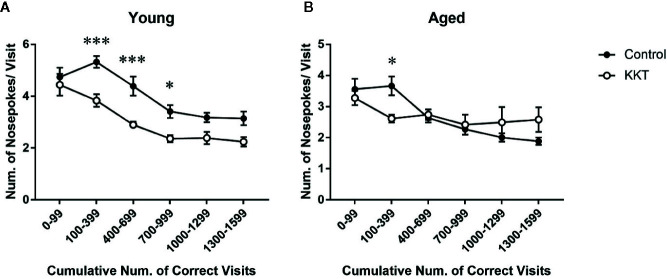
Effects of KKT on perseverative NPs of young (A) and aged (B) mice during the learning sessions. Data were collected every 300 corner visits except for the initial part of learning during which data were measured in 100 visits. All data are presented as mean ± SEM. n = 8, two-way repeated measures ANOVA followed by Bonferroni’s multiple comparison (*: P < 0.05; ***: P < 0.001).